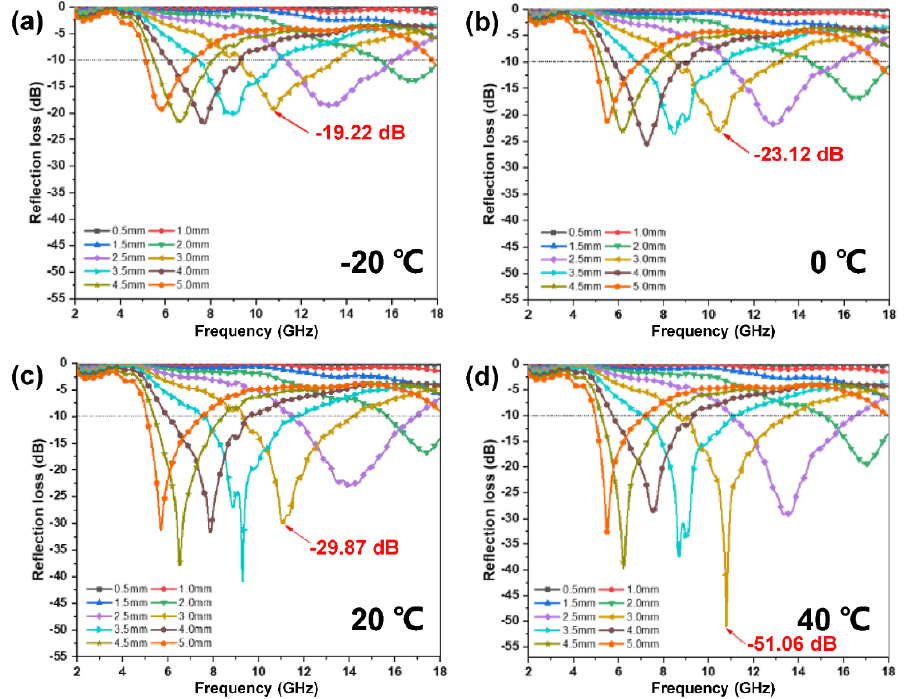
Figure 8. The EWA temperature dependence of the PU/WTR@CNT/Fe 3 O 4 — 1:2 composite foam at ( a ) −20 °C, ( b ) 0 °C, ( c ) 20 °C, and ( d ) 40 °C.